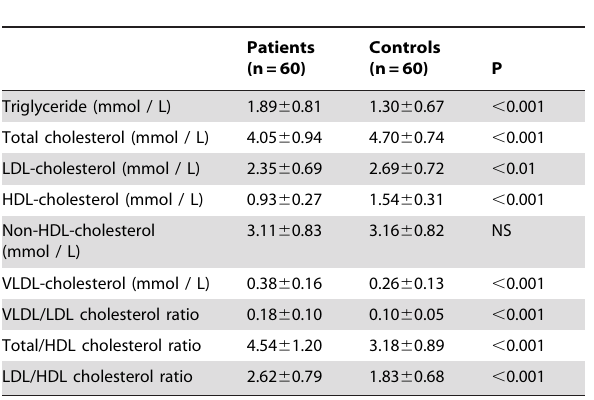
Table 2. Lipid profiles in untreated patients with early polymyositis and controls.